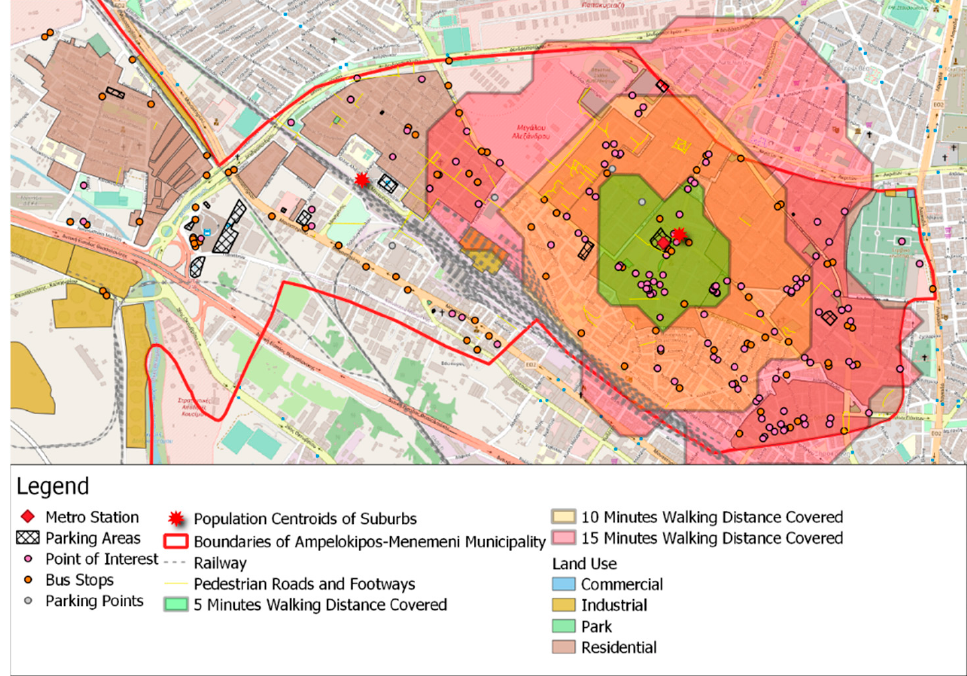
Figure 4. Walking distance of 5 min, 10 min, and 15 min from the metro station (Background map: © OpenStreetMap contributors [88]).